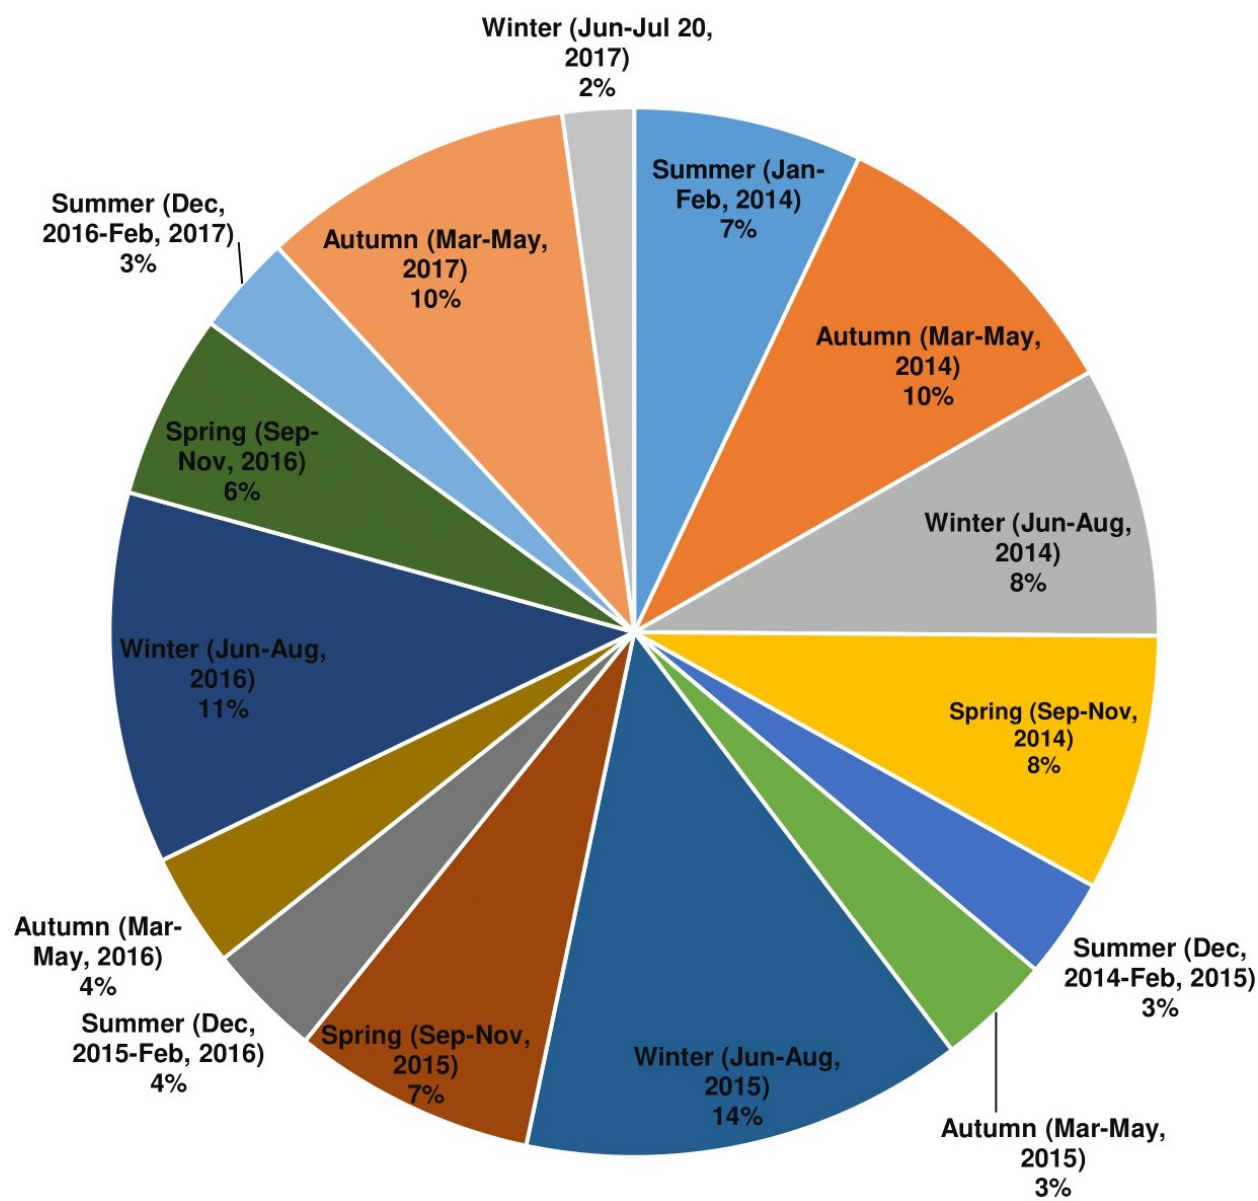
Figure 8. Historical trend of outages per